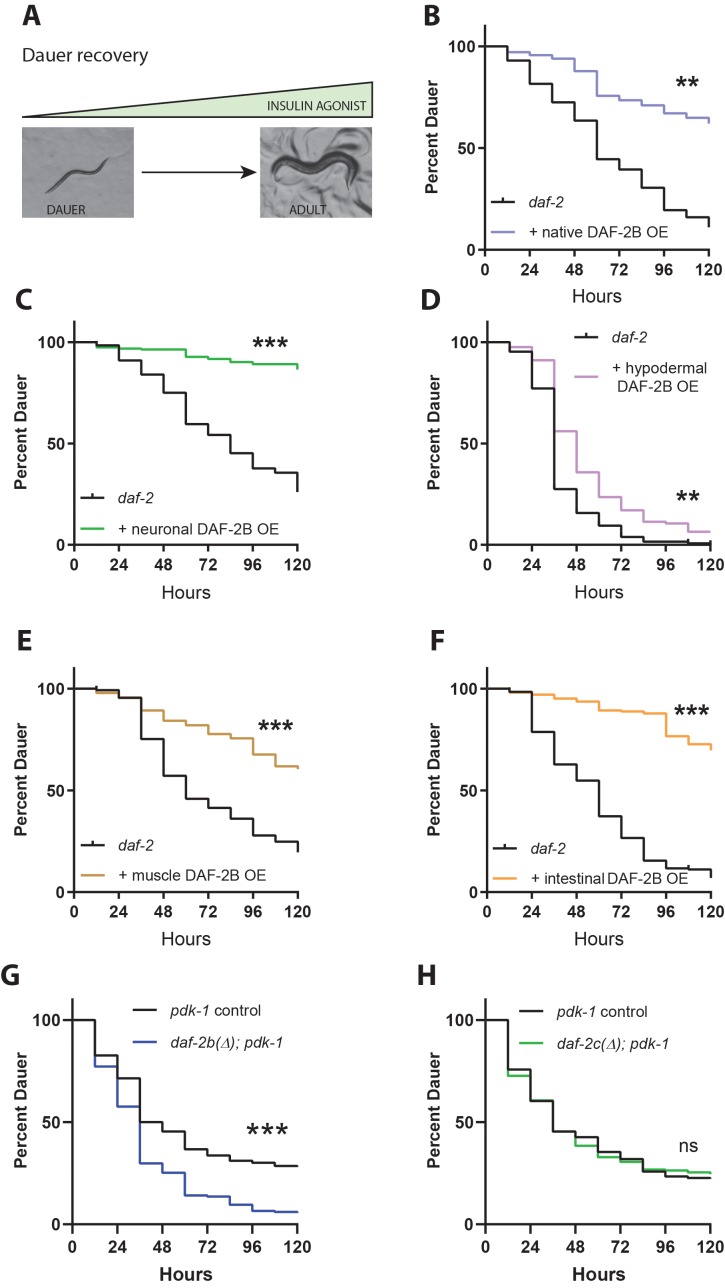
DAF-2B influences dauer recovery in temperature-sensitive insulin-signaling mutants.(A) Exit from the dauer larva into a reproductive adult requires an increase in the activity of insulin agonists. Overexpression of DAF-2B from the native daf-2 promoter (B), in the nervous system (C), in the hypodermis (D), in muscle (E) or in the intestine (F) inhibits dauer recovery in daf-2 mutants under permissive conditions. Data are pooled from three transgenic lines (except two for hypodermal and muscle promoters) with at least three technical replicates per transgene. Two additional trials with native, neuronal, muscle and intestinal DAF-2B OE showed similar effects. Raw data can be found in Figure 4—source data 1. (G) Genetic deletion of daf-2b promotes dauer exit in pdk-1 mutants. Data are pooled from six technical replicates from one control and one daf-2b(Δ) strain. Two biological repeats showed similar effects. Raw data can be found in Figure 4—source data 2. (H) Genetic deletion of daf-2c has no effect on dauer exit in pdk-1 mutants. Data are pooled from three technical replicates from each of 2 control and daf-2c(Δ) strains per trial. Two biological repeats showed similar effects. Log Rank test ns – not significant, **p<0.01, ***p<0.001. Raw data can be found in Figure 4—source data 2.Figure 4—source data 1.DAF-2B overexpression inhibits dauer recovery indaf-2(e1368).Figure 4—source data 2.daf-2bdeletion enhances dauer recovery inpdk-1(sa709).